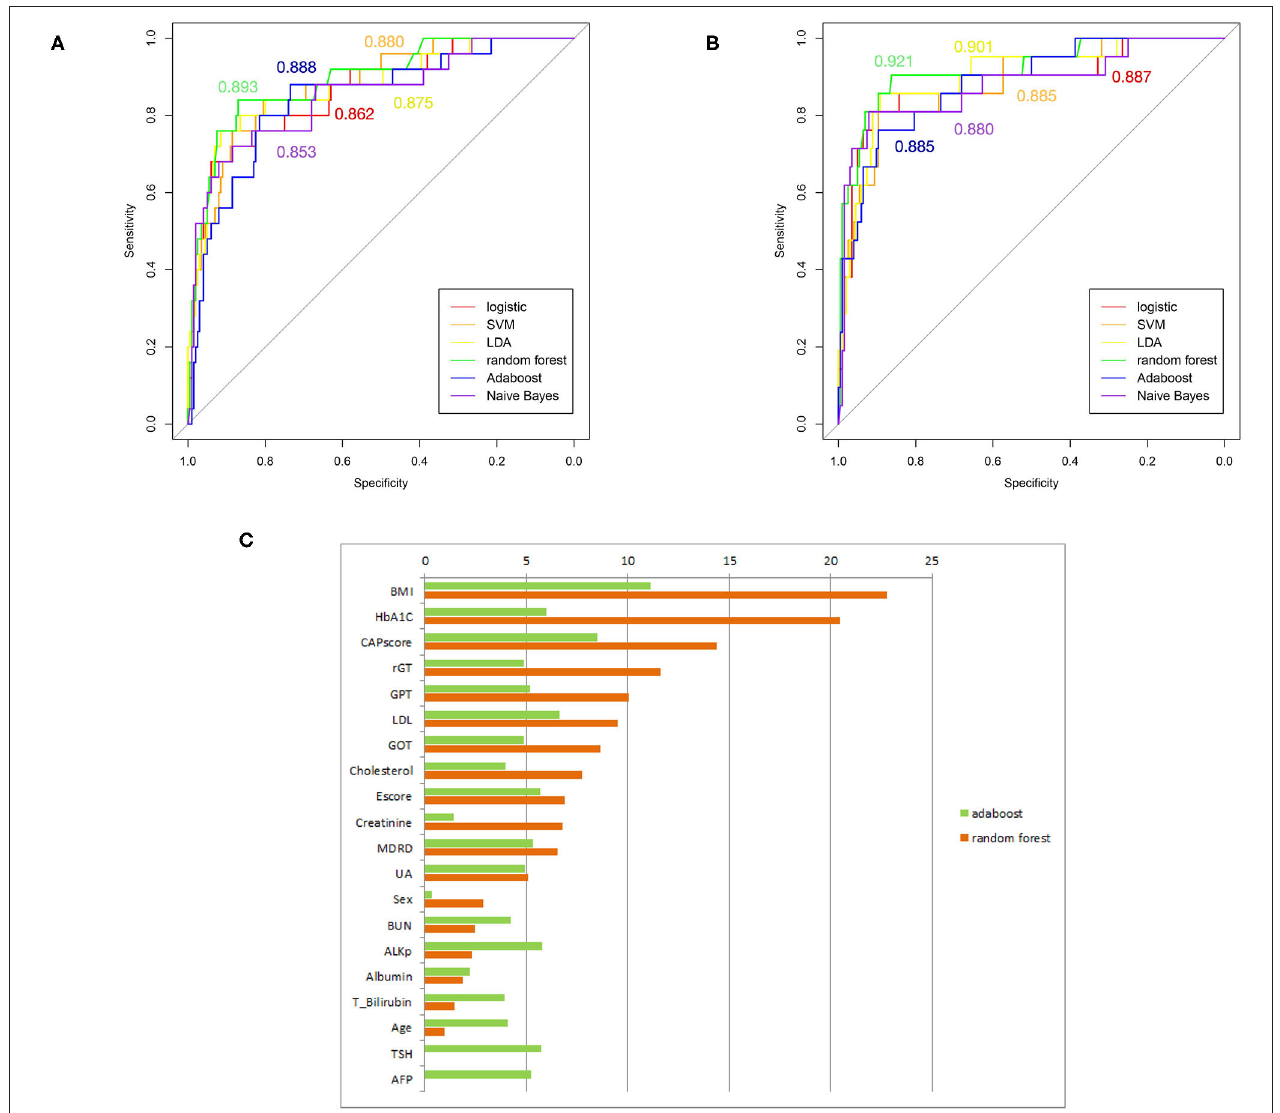
FIGURE 4 | (A) ROC curves of several machine-learning models based on the comparison of ATP III criteria. (B) ROC curves of several machine-learning models based on the comparison of IDP criteria. (C) Ranking of predictors according to ensemble learning. The respective C-statistics for each model, are given according to the chosen color for the